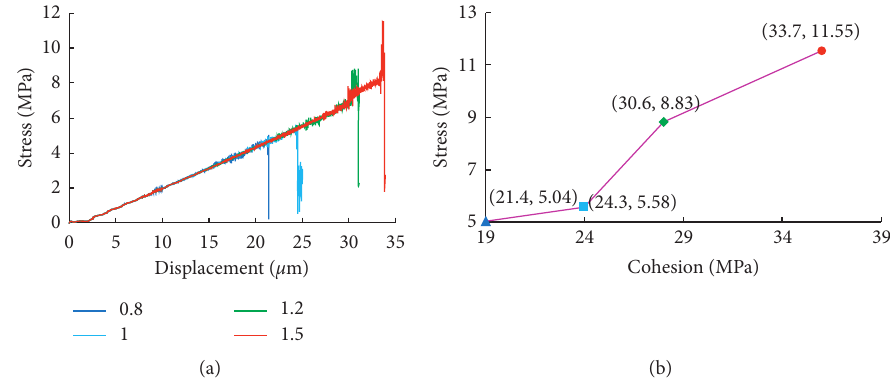
Figure 28: Stress-displacement changes at the center of cleavage of 45 ° bedding shale with different contact cohesion.